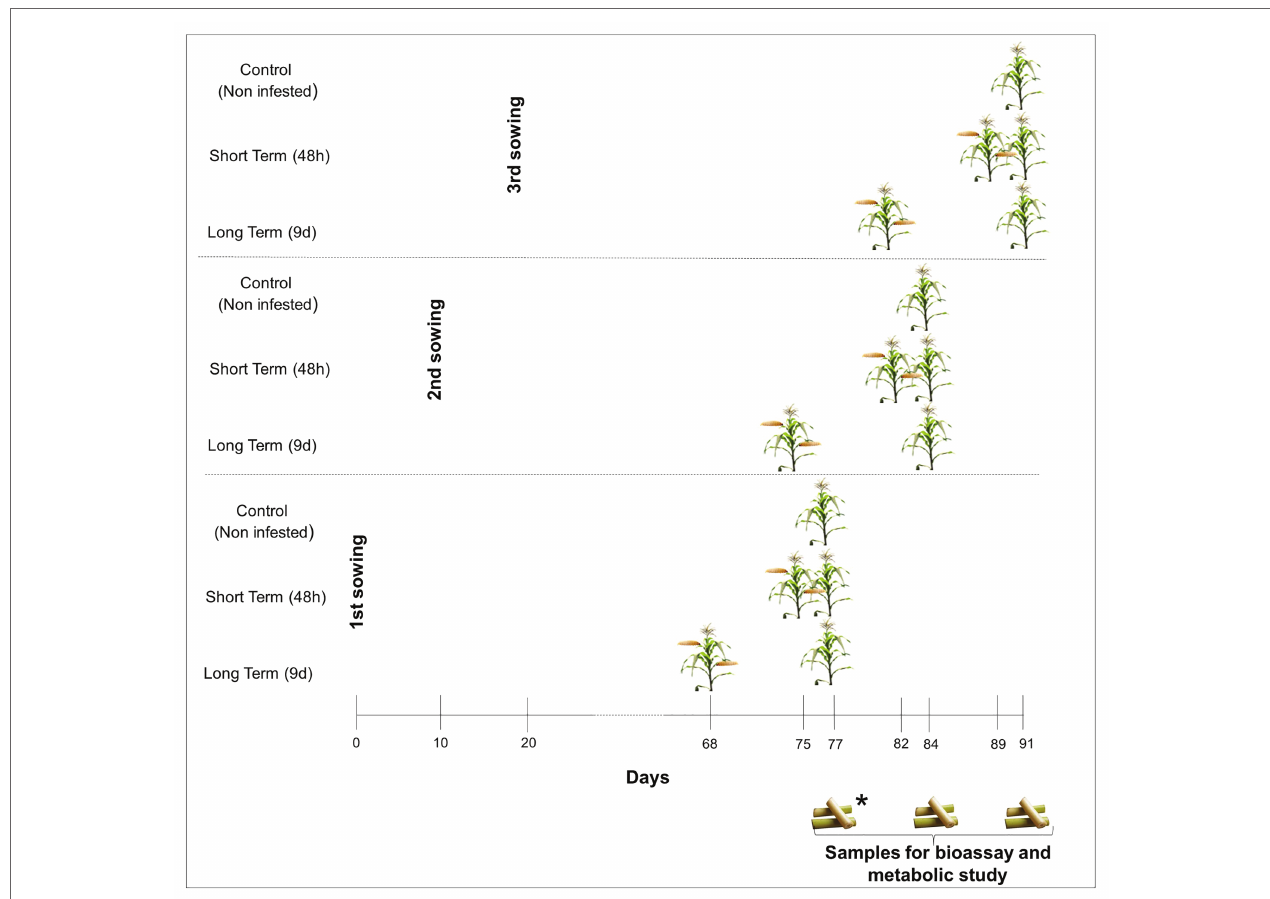
FIGURE 1 | Greenhouse experiment design. *Maize samples for establishment of the bioassay and metabolite characterization were taken 77 days after planting in the earliest planting. Maize tissues from the second and third plantings were taken at 84 and 91 days, respectively, to renew feeds for Mediterranean corn borer (MCB)